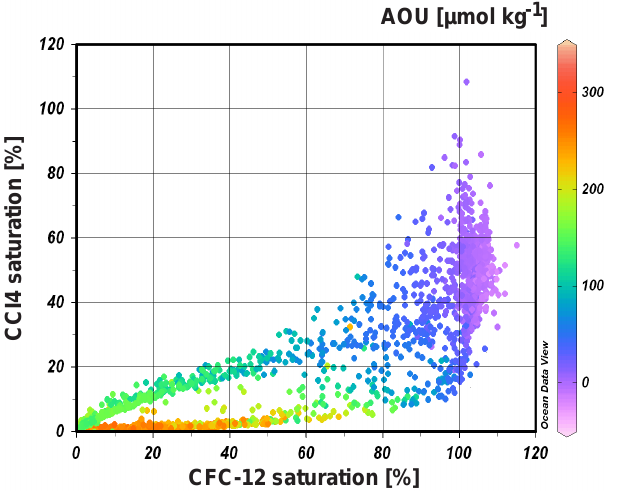
Figure 8. Various wind speed relationships for the air–sea exchange velocity ( K w,660 ) determined in previous studies. Curves from each of these studies were normalized to CO 2 , but as shown here, have been adjusted to represent CCl 4 according to its Schmidt number, which, as a function of viscosity of the medium and diffusivity of the gas, is largely a function of sea surface